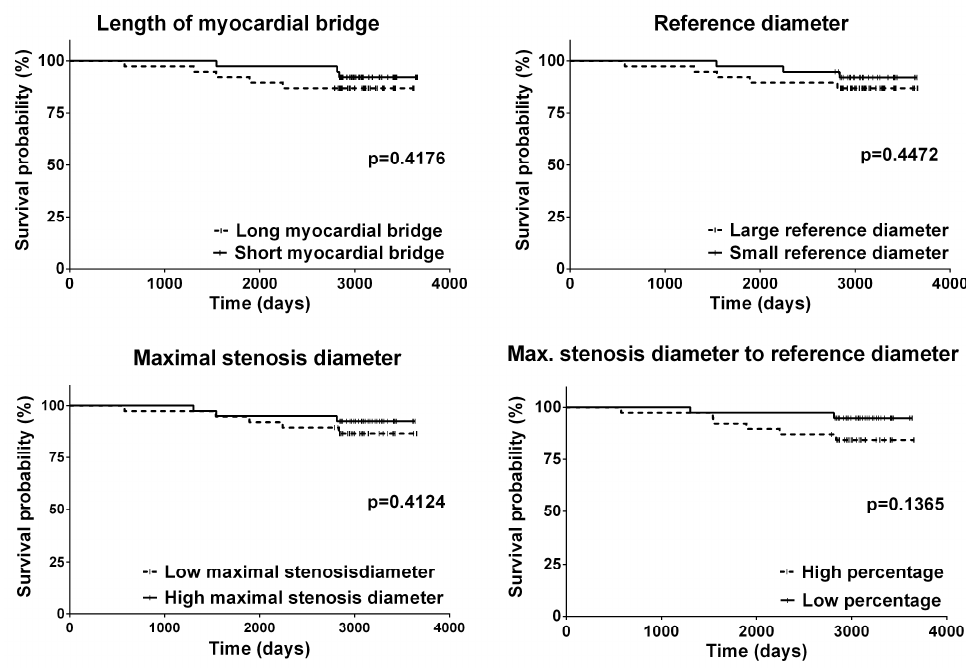
Figure 4. Kaplan–Meier curve of the long-term follow-up comparing morphological features of the myocardial bridge in LAD-MB neg (left anterior descendent myocardial bridge without another significant atherosclerotic coronary lesion) group. For this analysis, median values were used to dichotomize continuous variables. None of the morphological characteristics influenced the mortality rate.